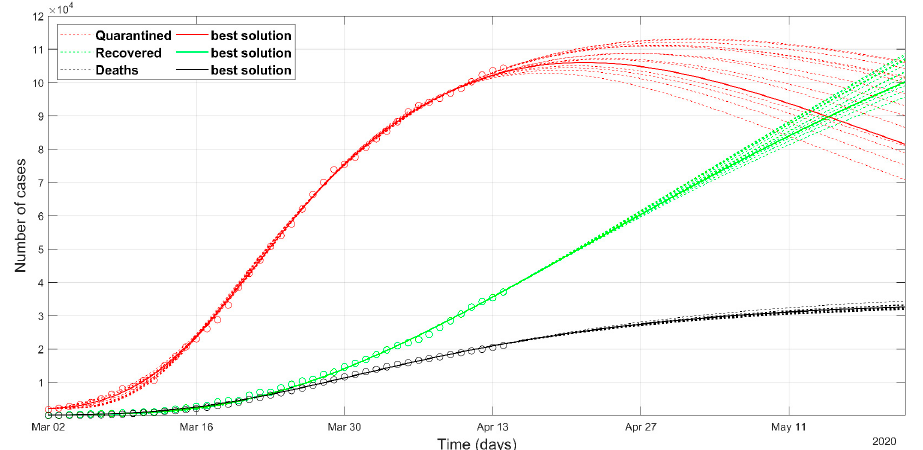
Figure 3. Observed data ( circles ) of quarantined ( red ), recovered ( green ) and deaths ( black ) for Italy, updated on 15 April 2020. The continuous lines refer to the predicted evolution in 30 days according to the SEIR model solved with the stochastic approach. The solid line refers to the best Particle Swarm Optimization (PSO) solution, the dashed lines refer to the most probable solutions (i.e., the solutions within 5% of the minimum normalized root mean square error